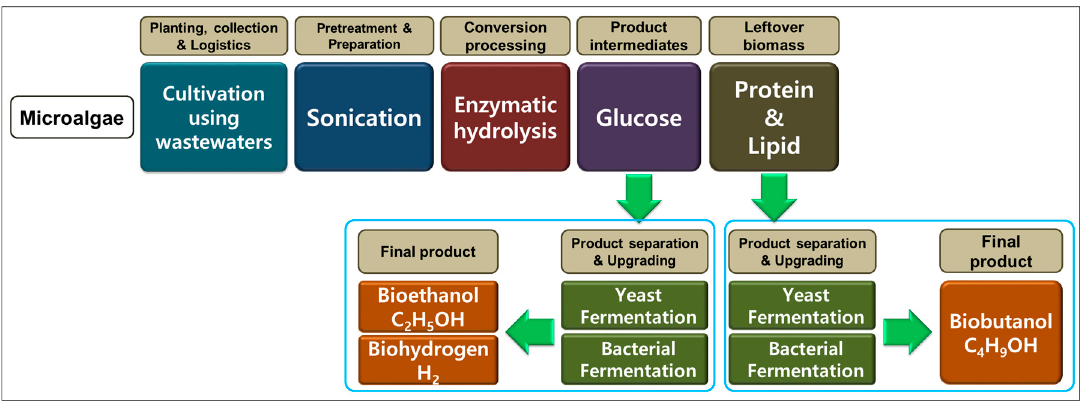
Figure 2. Microalgal technology for biofuel production through serial processes of cultivation, pretreatment, and conversion of each biocompounds.